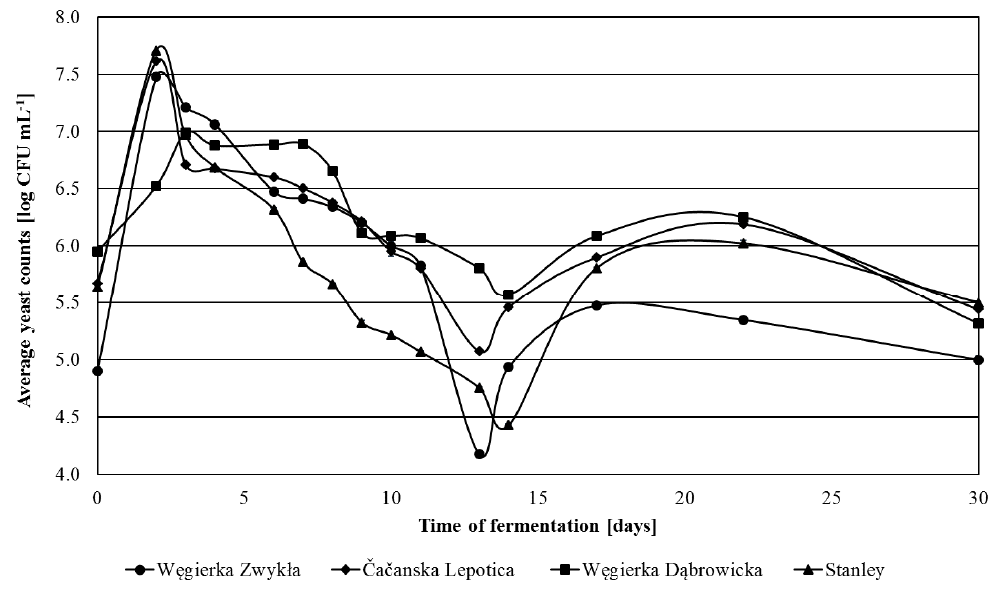
Figure 3. Kloeckera / Hanseniaspora yeasts 2012 season in the course of fermentation, n = 3, STD <